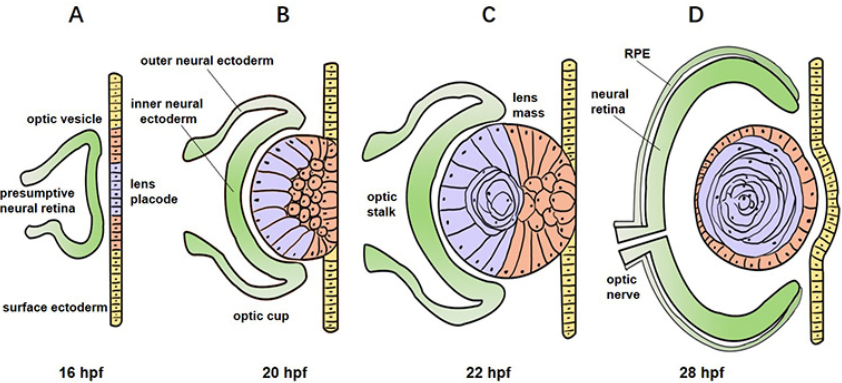
Figure 3. Schematic diagram indicating the development of zebrafish eye. The optic vesicle and lens placode are formed as the central eye field splits at 16 hpf ( A ). The distal portion of the optic vesicle invaginates so that a double-walled cup structure composed of an inner and outer neural ectoderm can be seen by 20 hpf ( B ). The optic cup grows circumferentially. The lens placode gives rise to a solid lens mass due to progressive delamination of the surface ectoderm cells by 22 hpf ( C ). The inner layer of the optic cup gives rise to the neural retina, while the outer layer differentiates into the RPE by 28 hpf ( D ). Finally, cells of the central lens placode move to the posterior lens mass and give rise to primary lens fiber cells (purple); cells of the peripheral lens placode migrate to the anterior lens mass to form the anterior epithelium (orange); the cornea (yellow) develops when the lens placode closes after the lens mass, taking apart from the surface ectoderm.